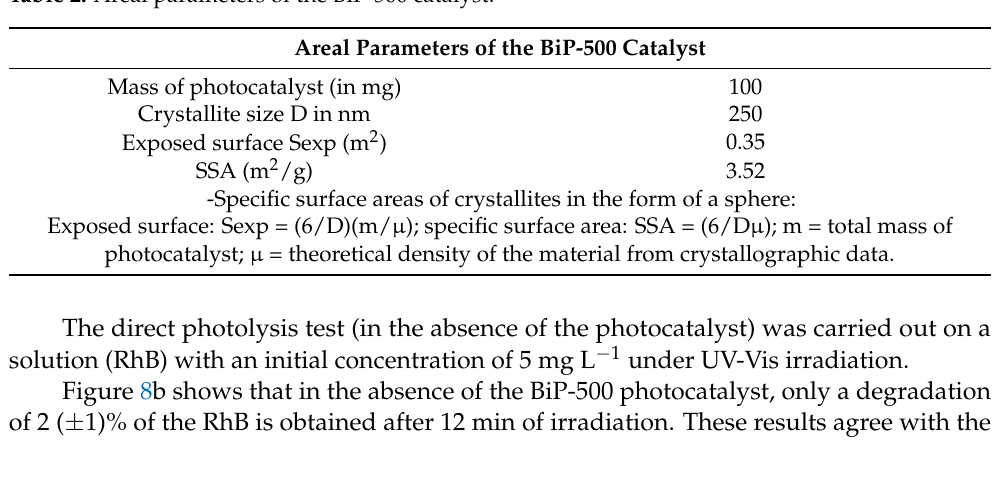
Figure 9. Distributions of particle sizes of BiP-500 photocatalyst. Table 2. Areal parameters of the BiP-500 catalyst.